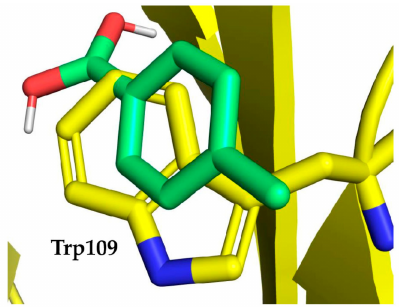
Figure 7. Fragment probe pose in comparison with the native residue—the case of Trp. Docking pose number 8 for p -toluene boronic acid fragment probe in comparison with the native residue chain B Tyr109, mutated to